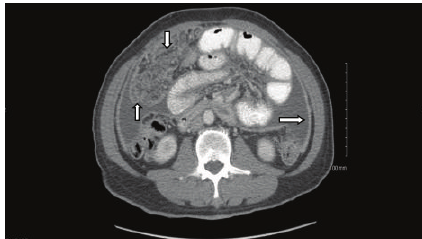
Figure 4: Exploratory laparotomy with round ligament and peri- toneal biopsies revealed numerous necrotizing